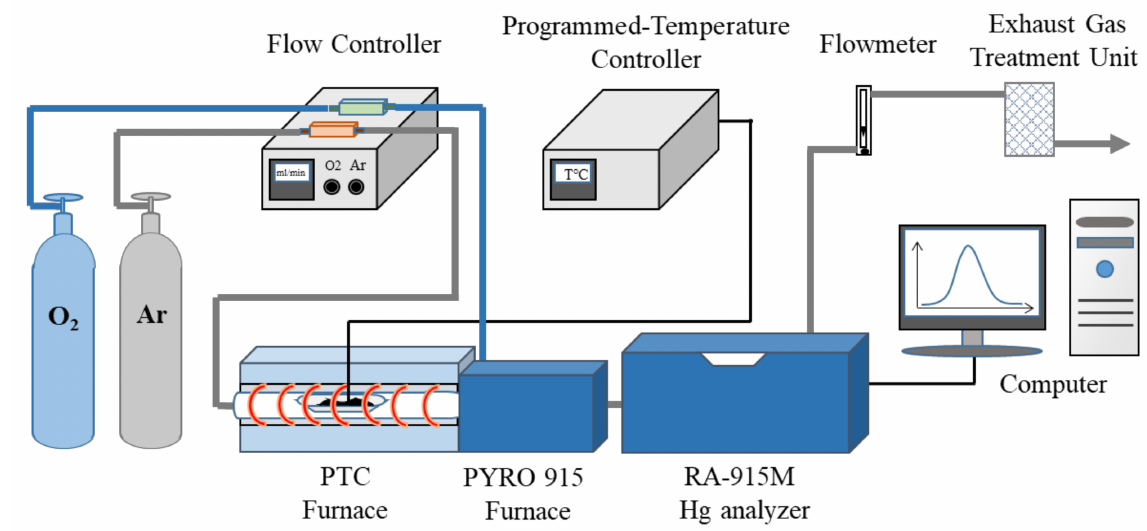
Figure 3. Schematic diagram of the TPD experimental